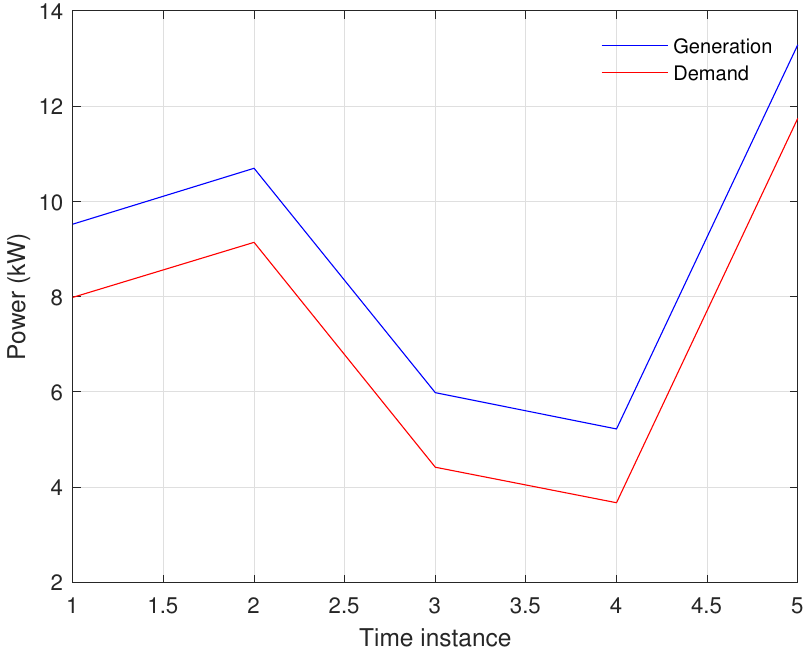
Figure 9. Demand and supply profile during shortfall after SLS for data